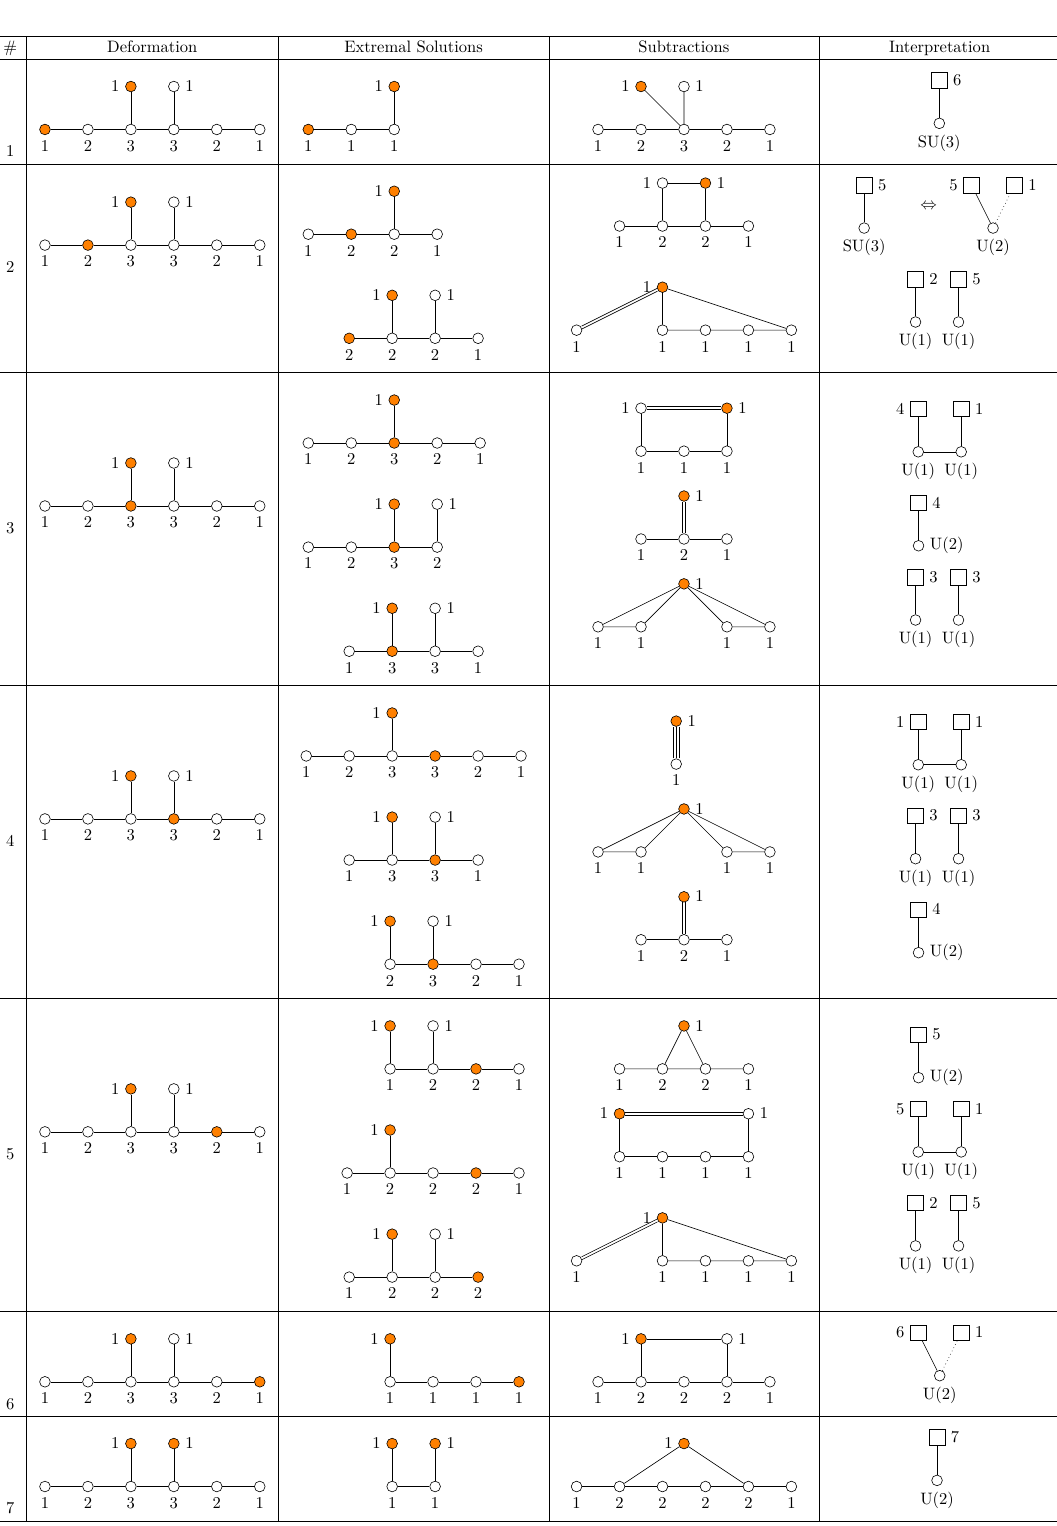
Table 3 . Analysis for SU(3) with 7 flavors